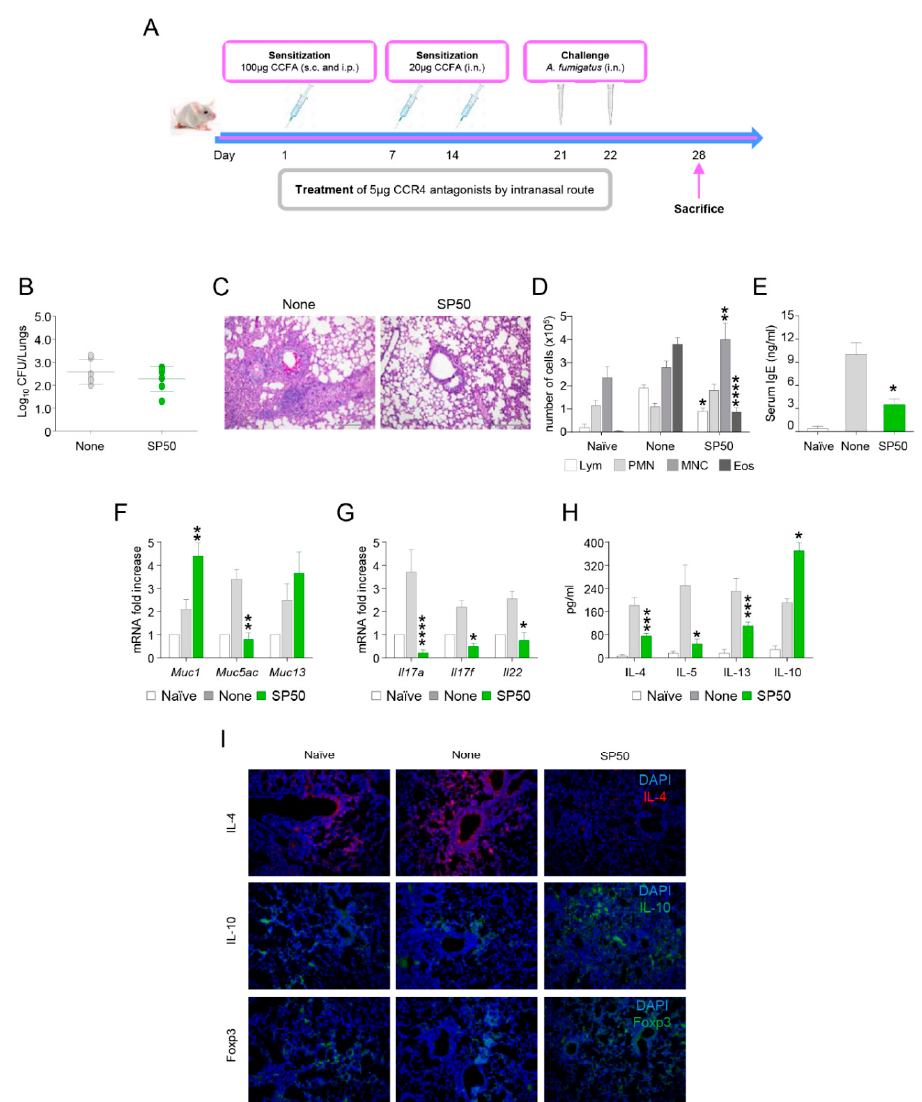
Figure 3. SP50 protects mice from allergic bronchopulmonary aspergillosis. ( A ) Representation of the murine experimental model of allergy. C57BL/6 mice was sensitized by the concomitant intraperitoneal (100 µ g) and subcutaneous (100 µ g) administration of A. fumigatus culture filtrate extract followed 1 week later by the intranasal instillation of 20 µ g of the extract. After an additional 7 days, bronchial colonization of A. fumigatus was induced by resting conidia administered i.n. (2 × 10 7 ), and the animals were evaluated 1 week later for parameters of allergic airway inflammation. Treatments included SP50 administered at 5 µ g/mouse/i.n. twice, in concomitance with the first and second CCFA administrations. ( B ) Mice were assessed for fungal growth (Log10 CFU) in the lungs at 1 week post-infection. ( C ) Paraffin-embedded lung sections were stained with periodic acid-Schiff to visualize mucin, goblet cells, and inflammatory cells. ( D ) The abundance of eosinophils (Eos), monocytes (MNC), polymorphonucleates (PMN), and lymphocytes (Lym) was assessed in BAL fluid. ( E ) IgE antibodies were determined in sera. ( F , G ) Gene expression analysis in lungs was done by RT-PCR a week after the infection. ( H ) Cytokines were determined in lung homogenates 7 days after the infection by ELISA. ( I ) Immunofluorescence staining with anti-IL-4, anti-IL-10, and anti-Foxp3 antibody of lungs at 7 dpi. Cell nuclei were stained blue with DAPI. Representative images were acquired with a high-resolution Microscopy Olympus DP71 with a × 20 objective. Data are pooled from three independent experiments. Control, naïve C57BL/6 mice. *, p < 0.05, **, p < 0.01, ***, p < 0.001, ****, p < 0.0001, SP50-treated vs SP50-untreated (None)